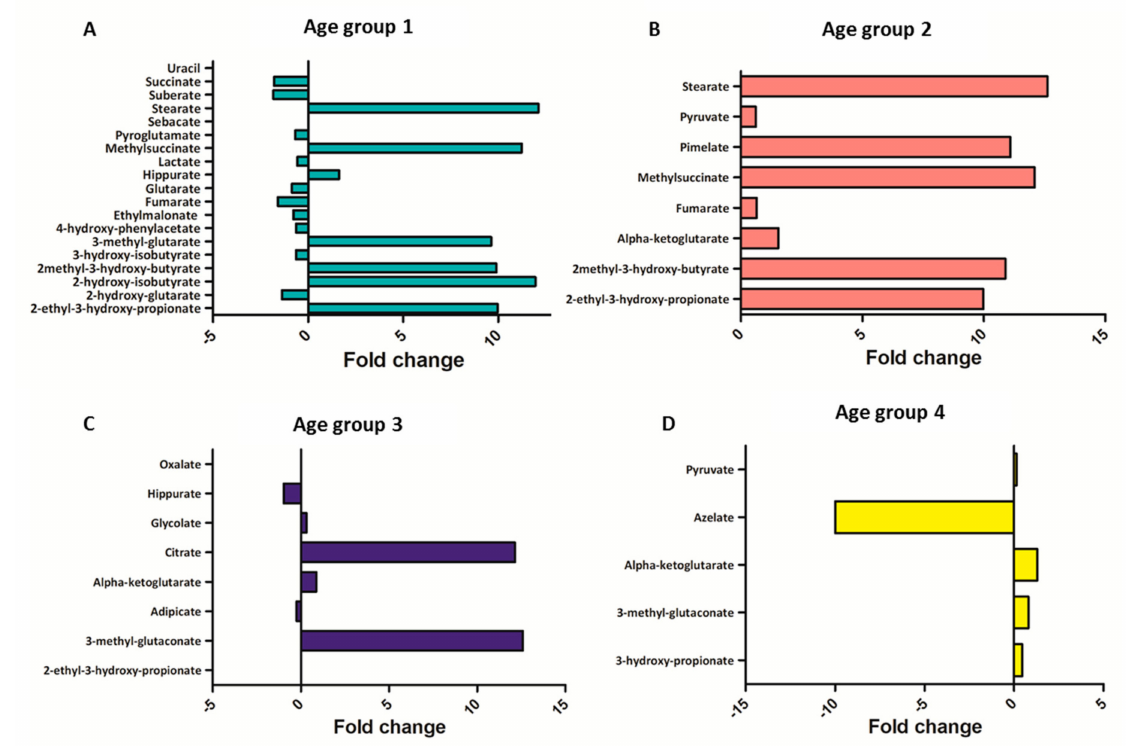
Figure 4. Fold change (log 2 female / male ratio) calculated for each sexually divergent metabolite in ( A ) age group 1; ( B ) age group 2; ( C ) age group 3; ( D ) age group